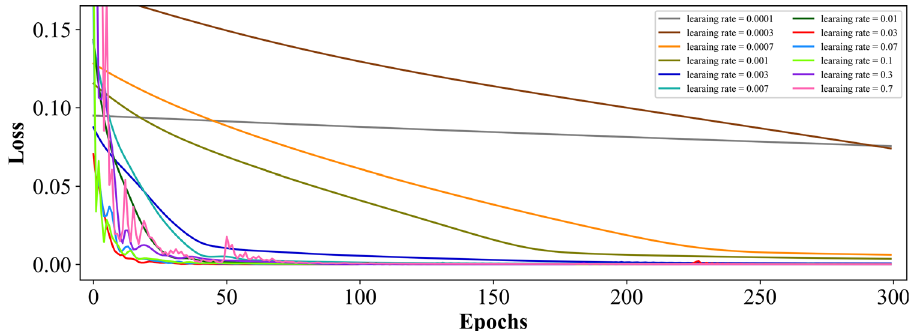
Fig. 10 Loss lines with different learning rates for the IMF1 of VMD for WZ